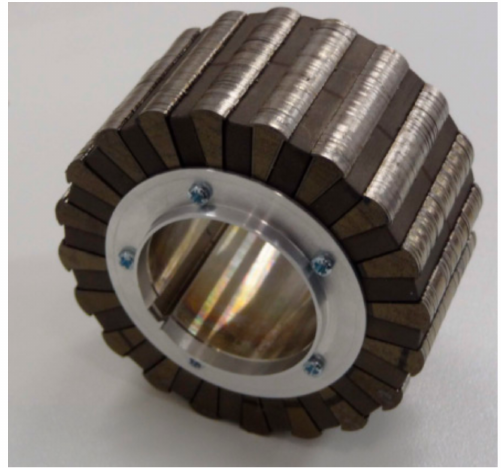
Figure 4. View of the designed